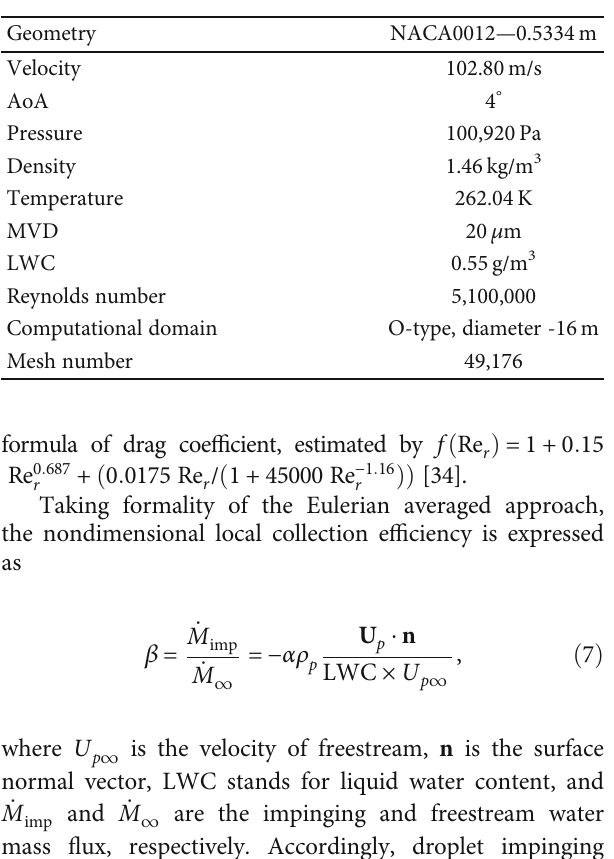
Figure 5: Comparison of simulation and experimental results in air fl ow fi elds. Table 2: Setup and inlet conditions of the droplet impingement validation case over a 2D NACA0012